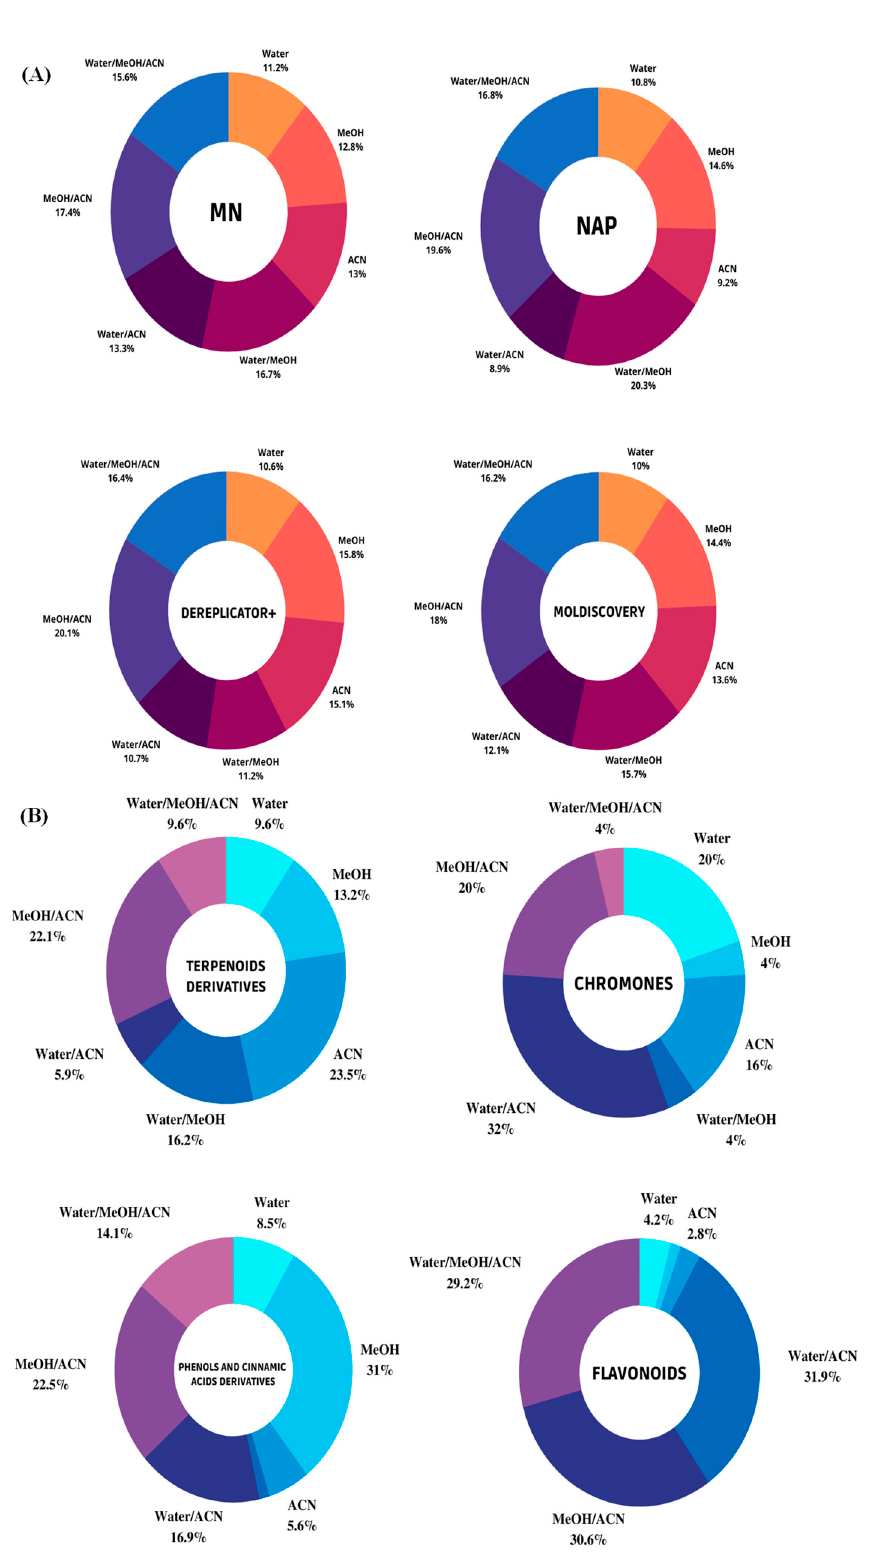
Figure 1. ( A ) Circle diagrams illustrate the percentages of unique metabolites obtained by classical molecular networking (MN), Dereplicator+, Moldiscovery, and NAP fusion from LC-MS spectra of cupuassu ( T. grandiflorum ) pulp extracts. ( B ) Impact of solvent used on the percentage of major chem- ical classes detected by LC-HRMS/MS analysis in positive ion mode ESI incupuassu pulp